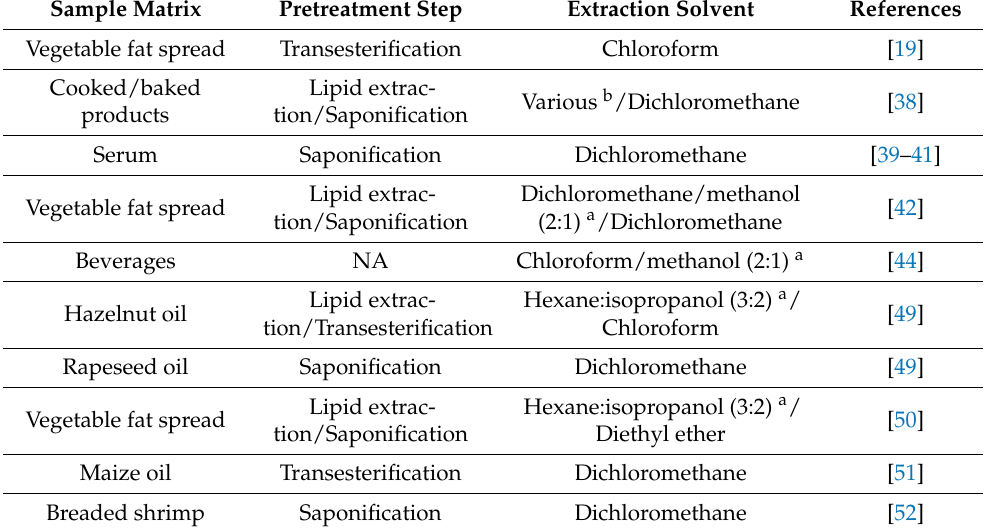
Table 1. Sample pretreatment procedures and organic solvents used during liquid–liquid extraction of